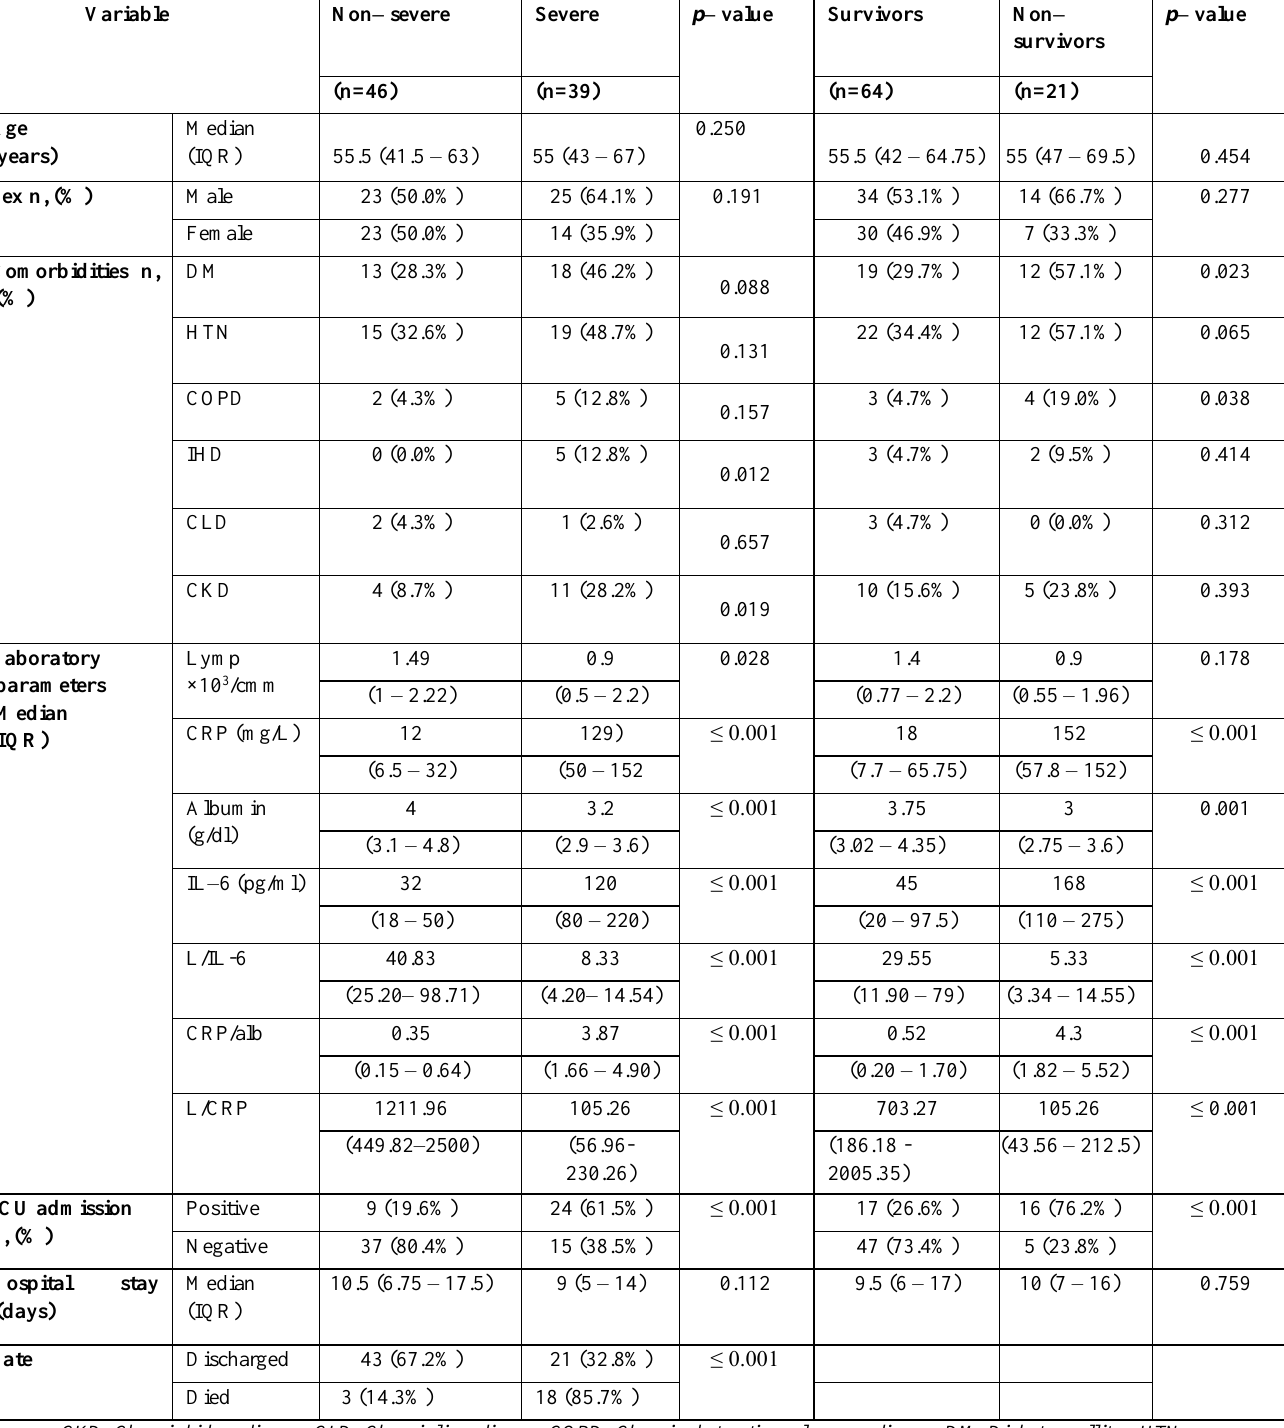
Table 2. Comparisons of baseline characteristics and laboratory findings according to COVID-19 severity and in-hospital